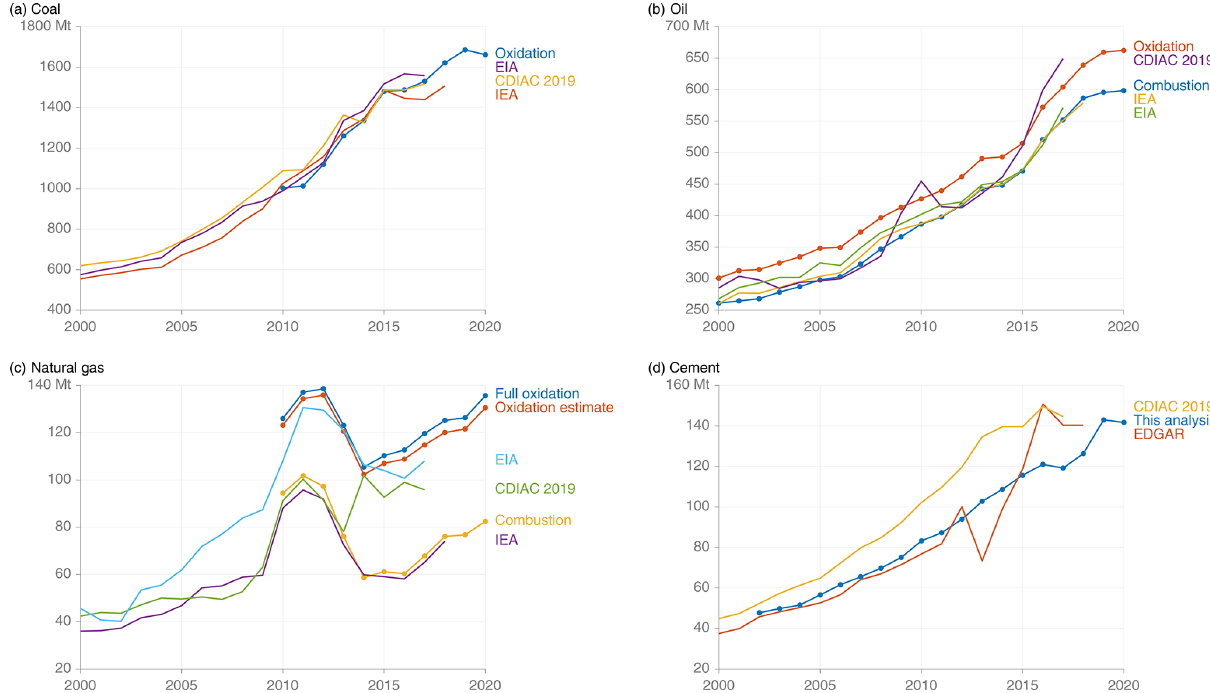
Figure 3. Comparison of financial-year emissions estimates with other datasets: (a) coal, (b) oil, (c) natural gas, and (d) cement. Sources: Gilfillan et al. (2019), IEA (2019a), Crippa et al. (2019), EIA (2020), own calculations.